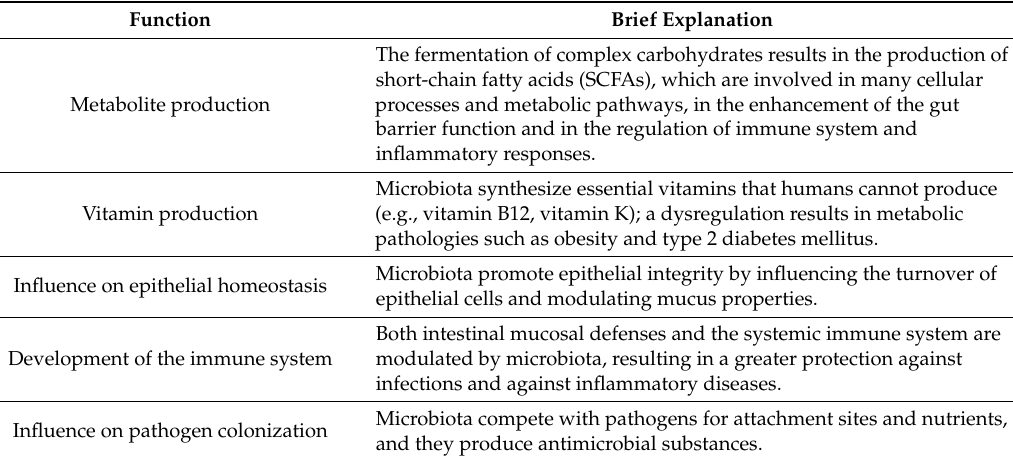
Table 1. Microbiota